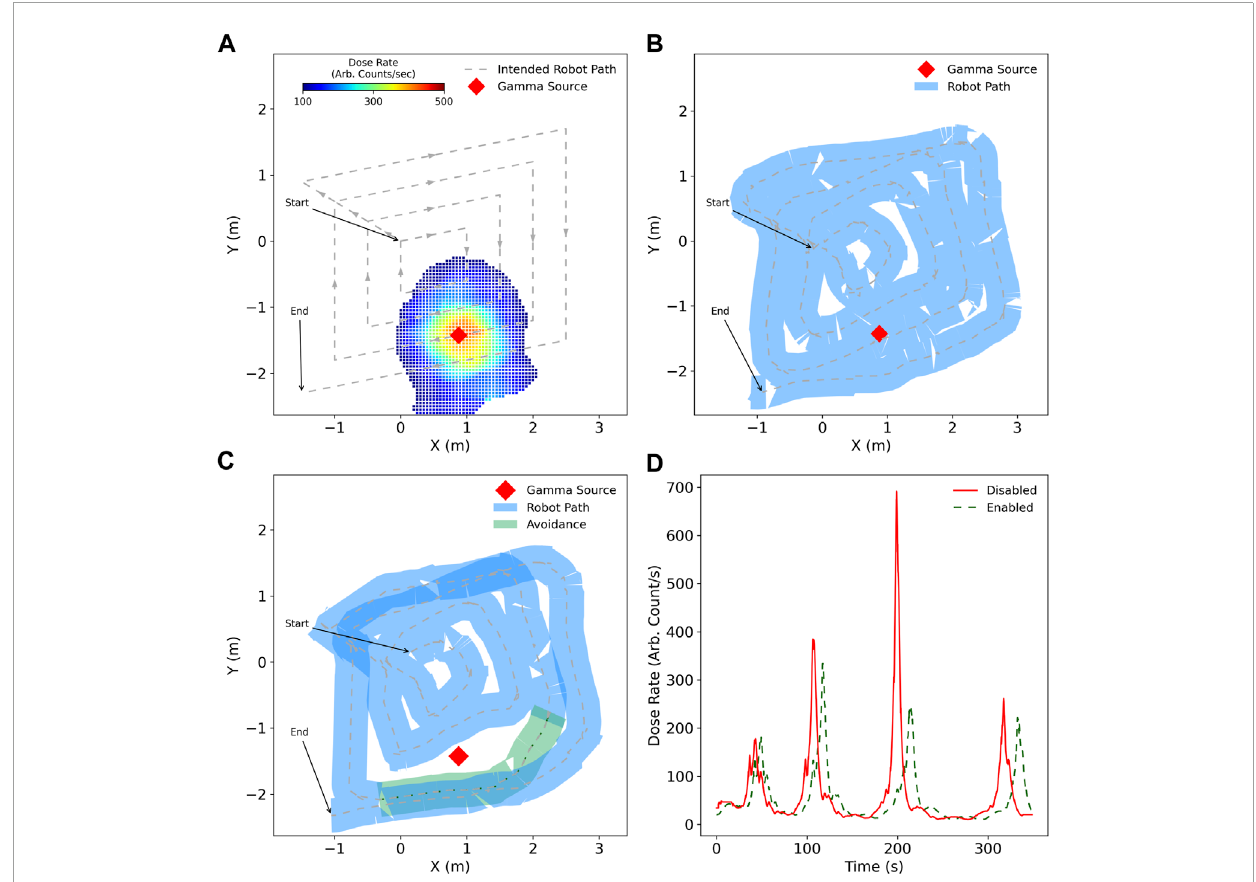
FIGURE 8 Coverage survey of four loops with no alpha radiation present but measurable gamma. (A) generated coverage path with location of gamma point source along path along with the interpolated gamma radiation field estimated by the robot, (B) actual robot path with no situational awareness of gamma radiation which brings it into close proximity, (C) the robot plans a path around the gamma source to decrease unnecessary exposure, (D) the difference in gamma radiation exposure during the entire autonomous